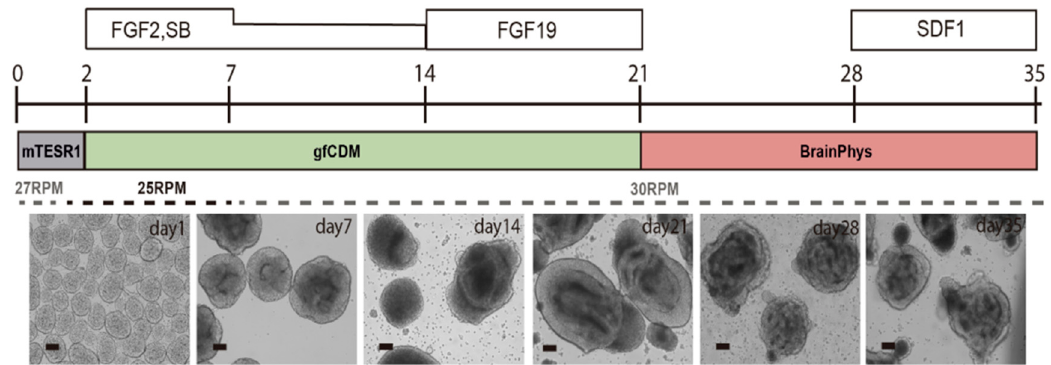
Figure 4. Directed differentiation of human iPSCs into cerebellar organoids in 0.1 L scale Vertical-Wheel bioreactor. Scale bar (100 μ m ).